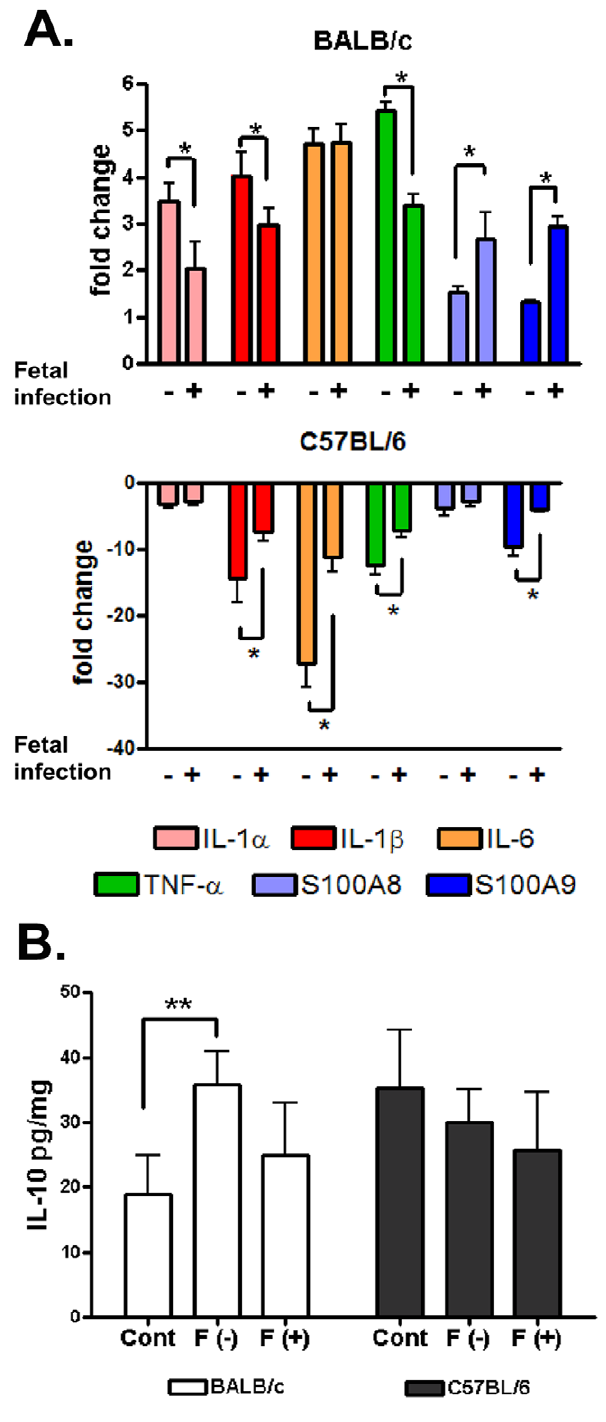
Figure 6. Placental inflammatory profiles in U.parvum infected BALB/c and C57BL/6 mice. ( A) Fold change (2 2 DD Ct ) is relative to normalized Ct values from sham inoculated controls, which was determined by the method of Schmittgen and Livak [72]. Values represent the mean 2 2 DD Ct 6 SD of 5 biological replicates from 3 independent experiments.* Indicates a significant difference (P , 0.01), which was determined by Student’s t test using 2 2 D Ct data. (B) Mean IL- 10 6 SD expressed as pg/gm weight of tissue of 5 biological replicates from 3 independent experiments. ** Indicates a significant difference (P , 0.03).